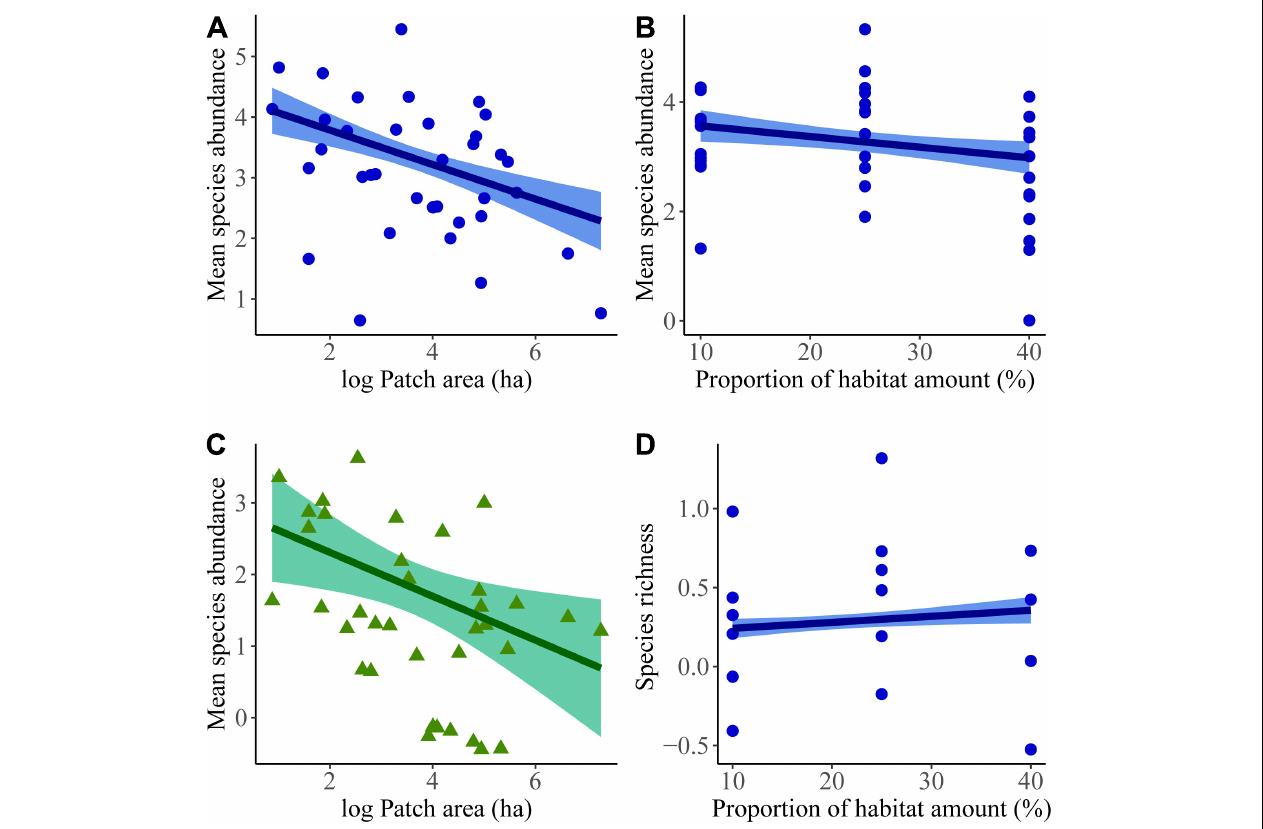
FIGURE 2 | Final regression models revealing the effects of landscape structure on small mammal community metrics in semideciduous forest patches in the Brazilian Cerrado, including: patch area (A) and proportion of habitat amount in the landscape (B) for the abundance of habitat generalists; the effect of patch area (C) for forest specialists, and the effect of proportion of habitat amount in the landscape (D) for generalist estimated species richness (Chao 1). Habitat generalists are represented in blue, forest specialists are shown in green.